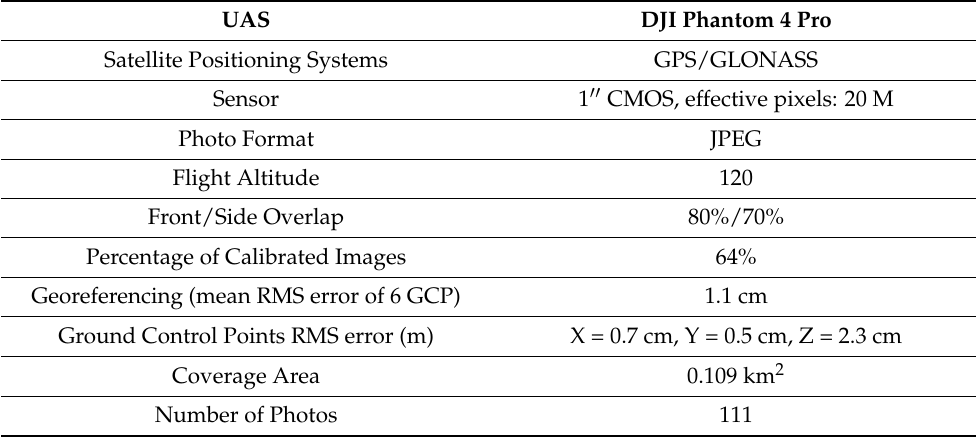
Table 1. UAS parameters and basic data related to image